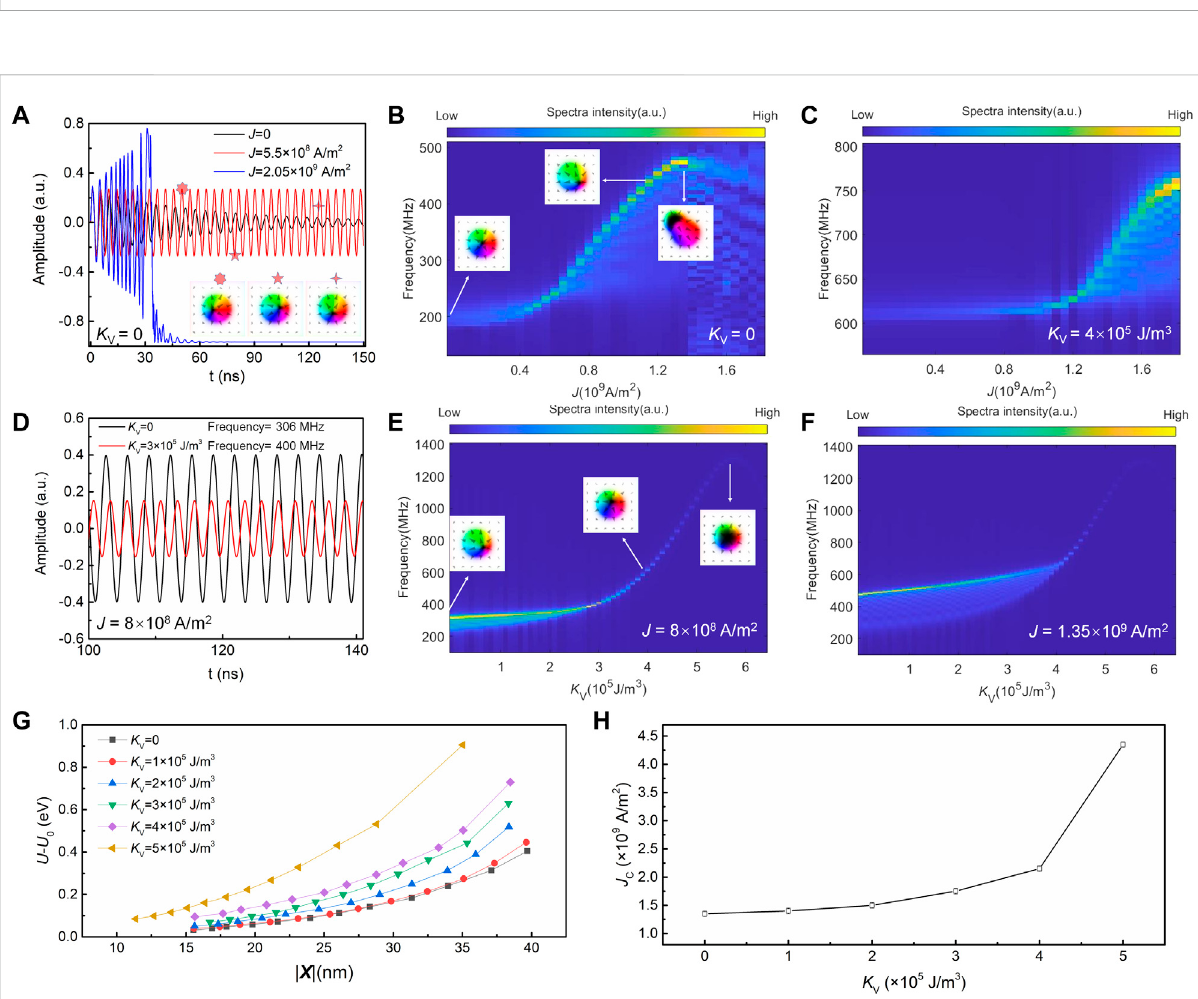
FIGURE 2 (A) Oscillationamplitudesof x componentofaveragemagnetisationinthevortexwhenthespinpolarisedcurrent J =0(black), J =5.5×10 8 A/m 2 (red) and J =2.05×10 9 A/m 2 (blue).Dependenceofoscillationfrequencyon J for (B) theanisotropyconstantofvortexregion K V =0and (C) K V =4×10 5 J/m 3 . (D) Oscillation amplitudes of x component of average magnetisation in the vortex region when K V = 0 (black) and K V = 3 × 10 5 J/m 3 (red) for J = 8 × 10 8 A/m 2 . Dependence of oscillation frequency on K V for (E) J = 8 × 10 8 A/m 2 and (F) J = 1.35 × 10 9 A/m 2 . (G) Dependence of the potential energy ( U ) on the variation of the core displacement (| X |) at different K V values. (H) The change of upper limit current density ( J C ) for the self-sustained oscillation with the change in K V